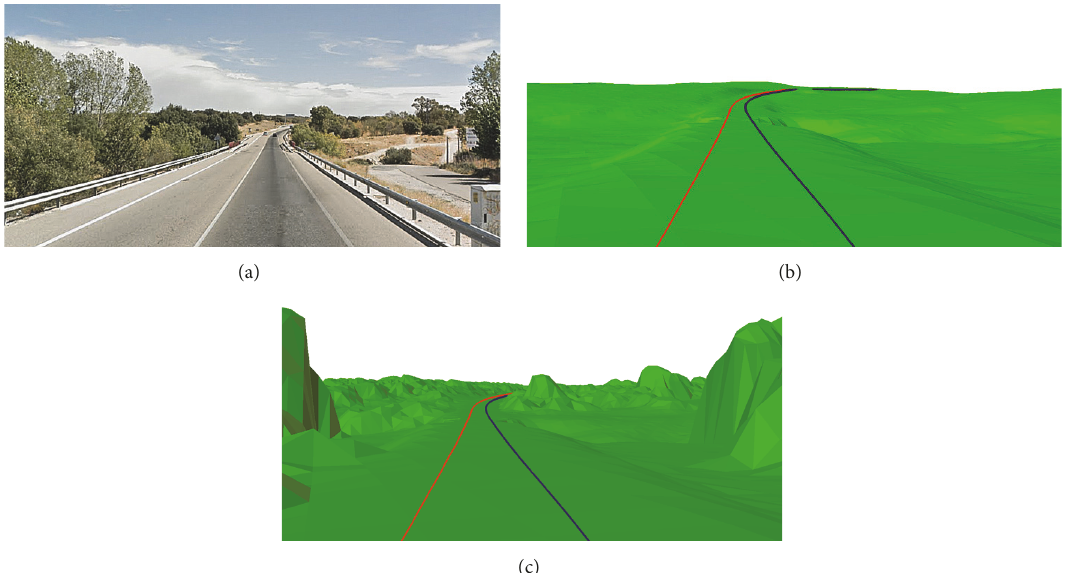
Figure 3: Example of 3D ASD modelling of highway M-607; (a) actual view of the highway segment, (b) 3D DTM modelling, and (c) 3D DSM